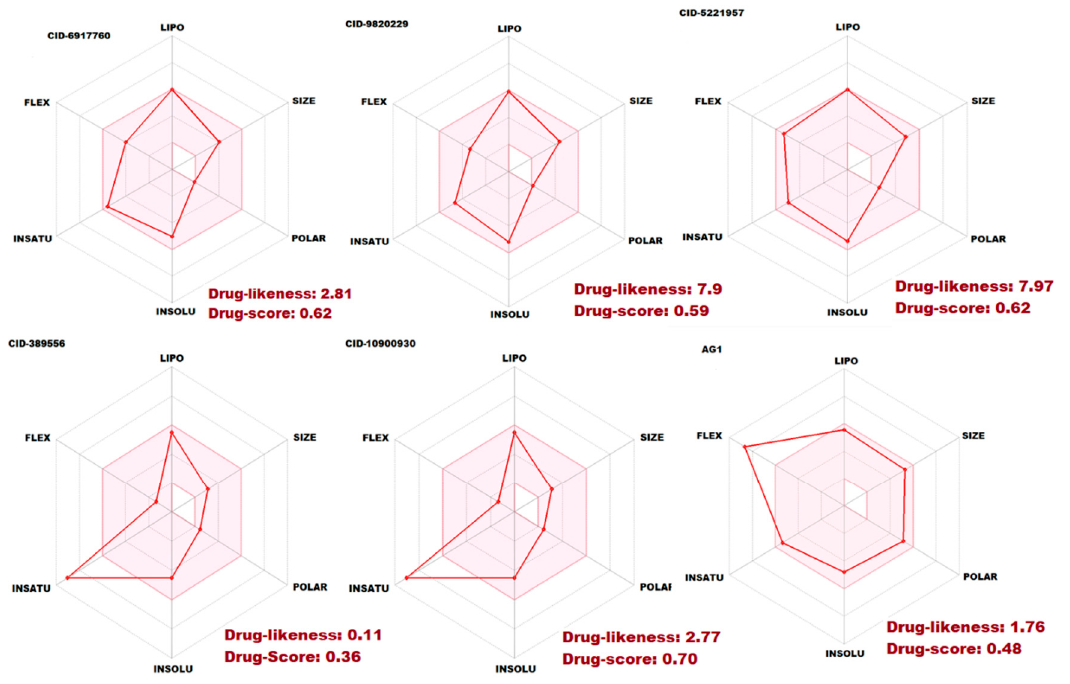
Figure 8. The ADMET properties of the five best G6PD small molecule activators CID6917760, CID9820229, CID5221957, CID389556, CID10900930, and AG1 (CID6615809). The pink area represents the optimal range for each properties (lipophilicity: XLOGP3 between ne − 0.7 and + 5.0, size: MW between 150 and 500 g / mol, polarity: TPSA between 20 and 130 Å 2 , solubility: log S not higher than 6, saturation: fraction of carbons in the sp3 hybridization not less than 0.25, and flexibility: no more than 9 rotatable bonds. Table 2. Physicochemical properties, lipophilicity, water-solubility, pharmacokinetics, drug-likeness, and medicinal chemistry properties of selected ligands determined by the SwissADME server.